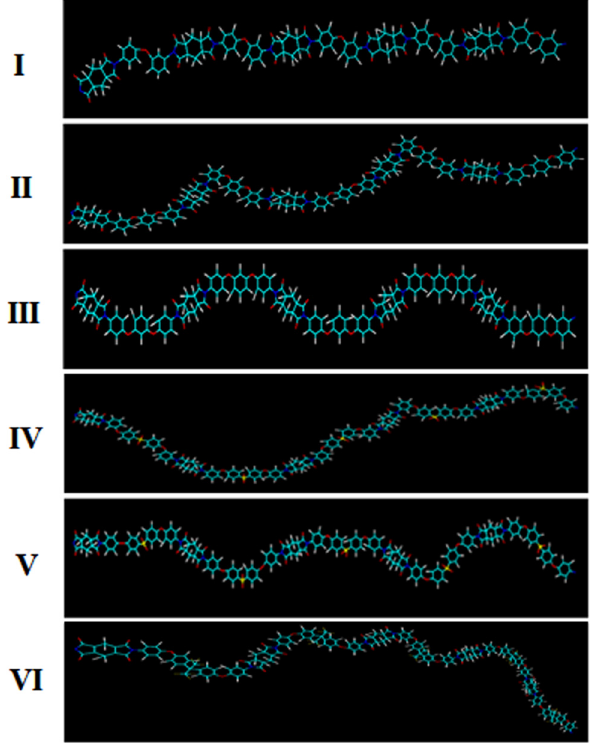
Figure 4: Comparison of the CPI three - dimensional chemical struc - tures with various diamines.